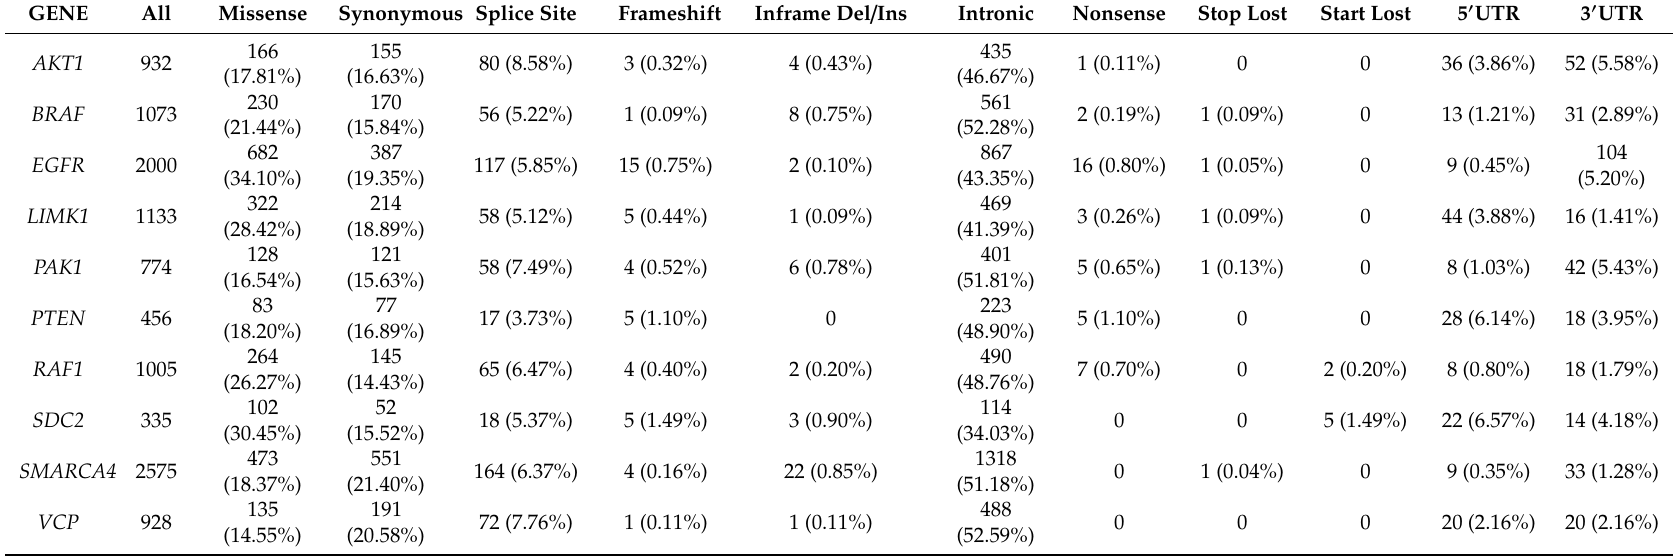
Table 2. Variants reported in gnomAD for the 10 candidate genes. The total numbers and percentages of variants are presented according to their